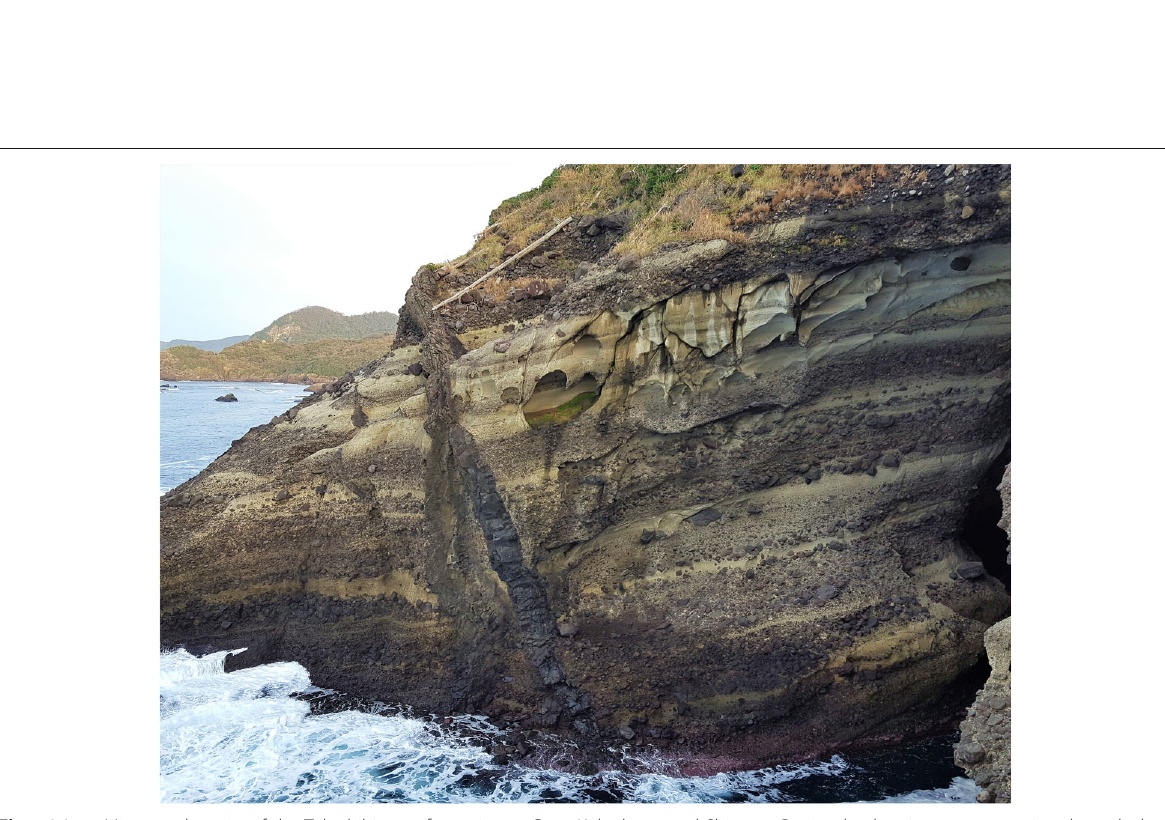
Fig. 10 Late Miocene deposits of the Takashibiyama formation at Cape Kukedo, central Shimane Peninsula, showing a cross section through the pyroclastic successions of a submarine seamount. A steeply dipping dike is crosscutting the volcaniclastic